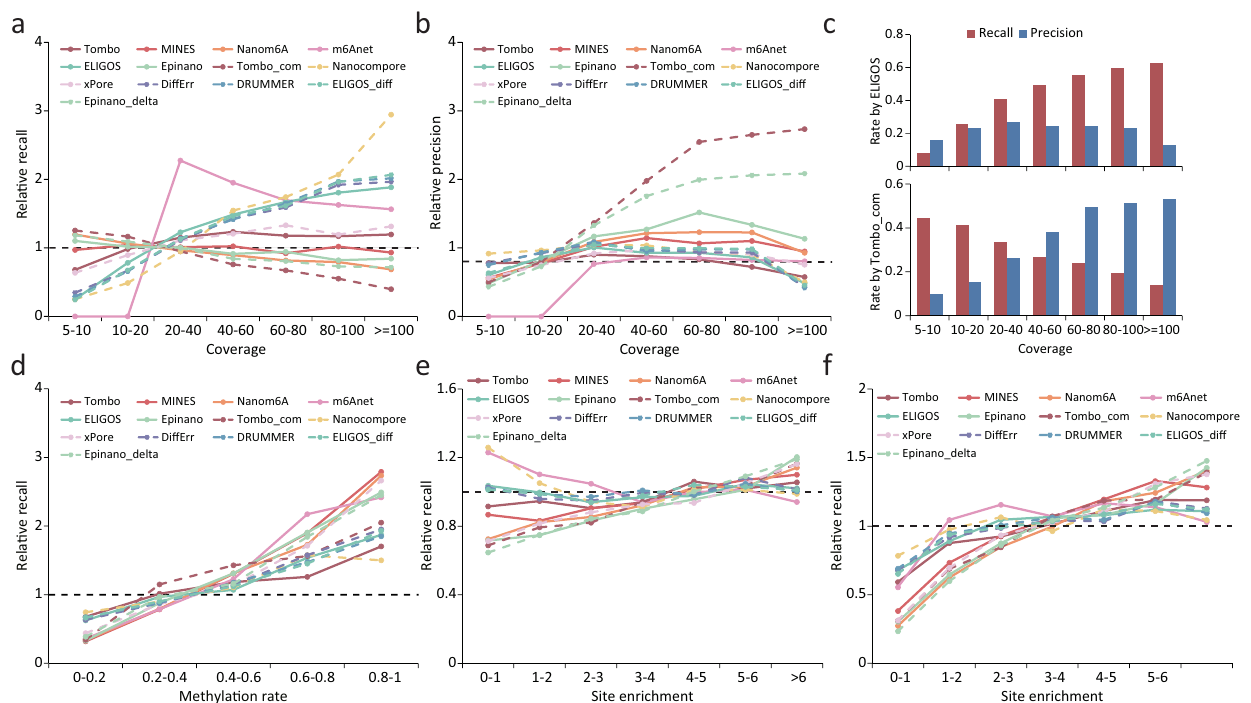
Fig. 6 | Detection sensitivity for m6A sites varies under different coverage and stoichiometry. a , b Relative recall rates ( a ) and precision ( b ) for m6A sites under differentcoverage.Relativerecallrates/precisionwerecalculatedastheratioofthe recallrate/precisionform6Asiteswithagivencoveragetotheoverallmean(across all sites). The validation set was derived from the miCLIP results. The same vali- dation set is also usedin c . c Recall rates and precisionofELIGOSand Tombo_com